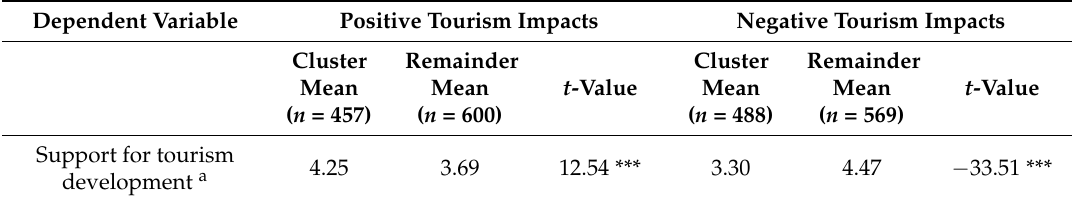
Table 4. Comparison of the mean values of the locally clustered perceptions of tourism impacts and of the rest of the